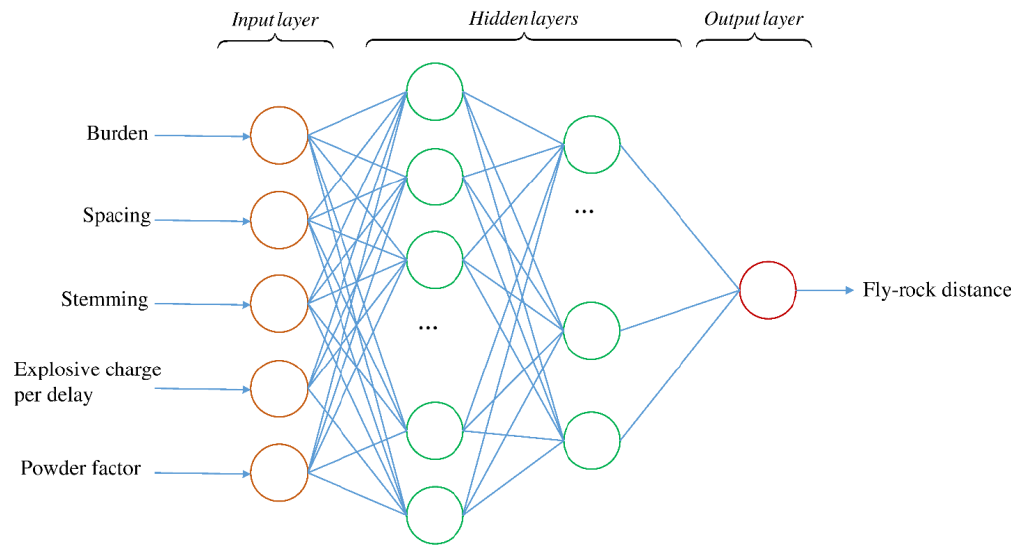
Figure 4. Artificial neural network (ANN) architecture for predicting blast-induced fly-rock efficiently.